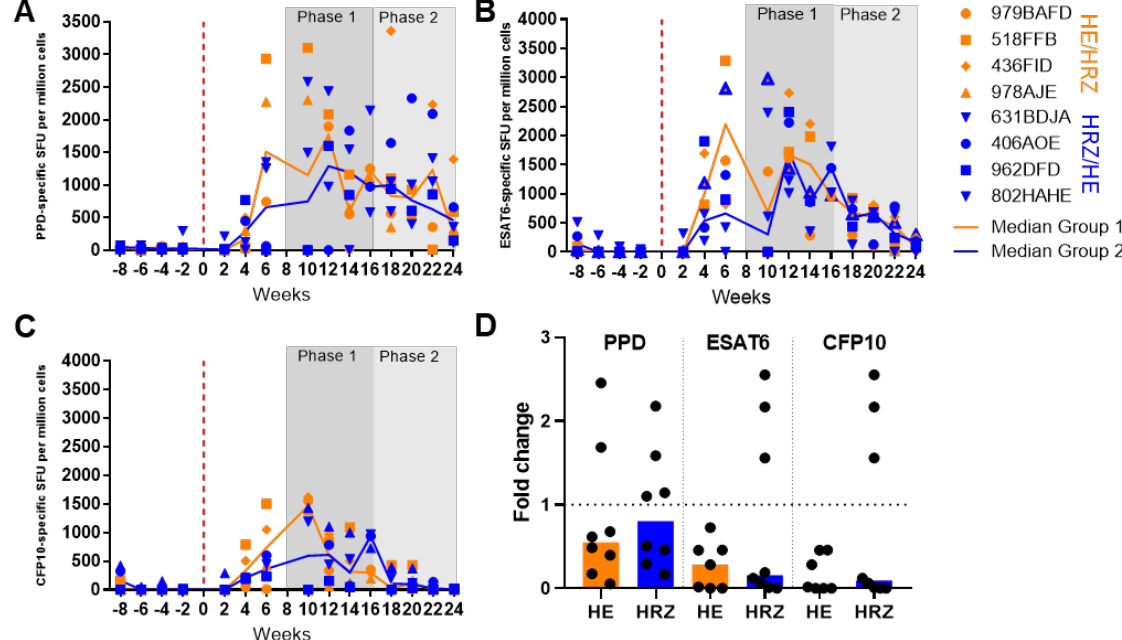
Figure 6. IFN- γ ELISPOT measurement of M. tb specific SFU in cynomolgus macaques infected with M. tb Erdman and following two treatment phases with different combinations of HRZ or HE ( A ) PPD-specific SFU, ( B ) ESAT6-specific SFU, ( C ) CFP10-specific SFU, ( D ) fold change SFU/million cells between the start and end of treatment phase, Orange = HE, blue = HRZ. Medians shown.